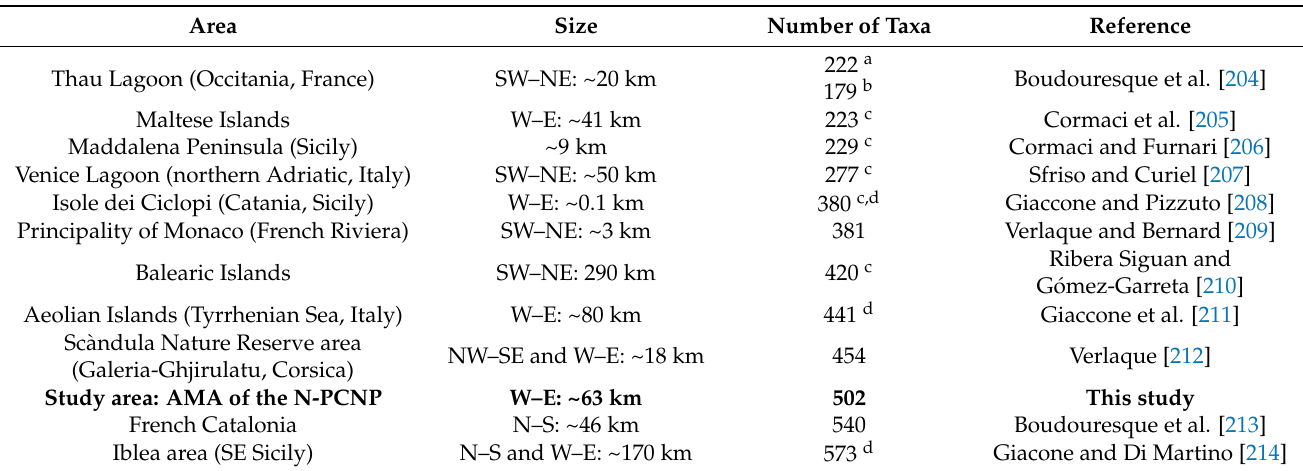
Table 1. Epsilon taxon diversity of macrophytes in a number of Mediterranean areas. The maximum distance (as the crow flies) between the outer limits of the area was used as a proxy for its size. Note that the research effort differs between